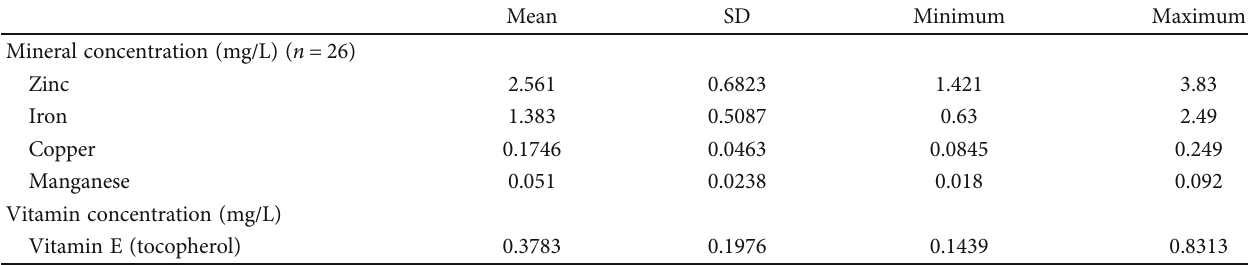
Table 2: Trace mineral pro fi le and vitamin E amount in Slovak raw goat